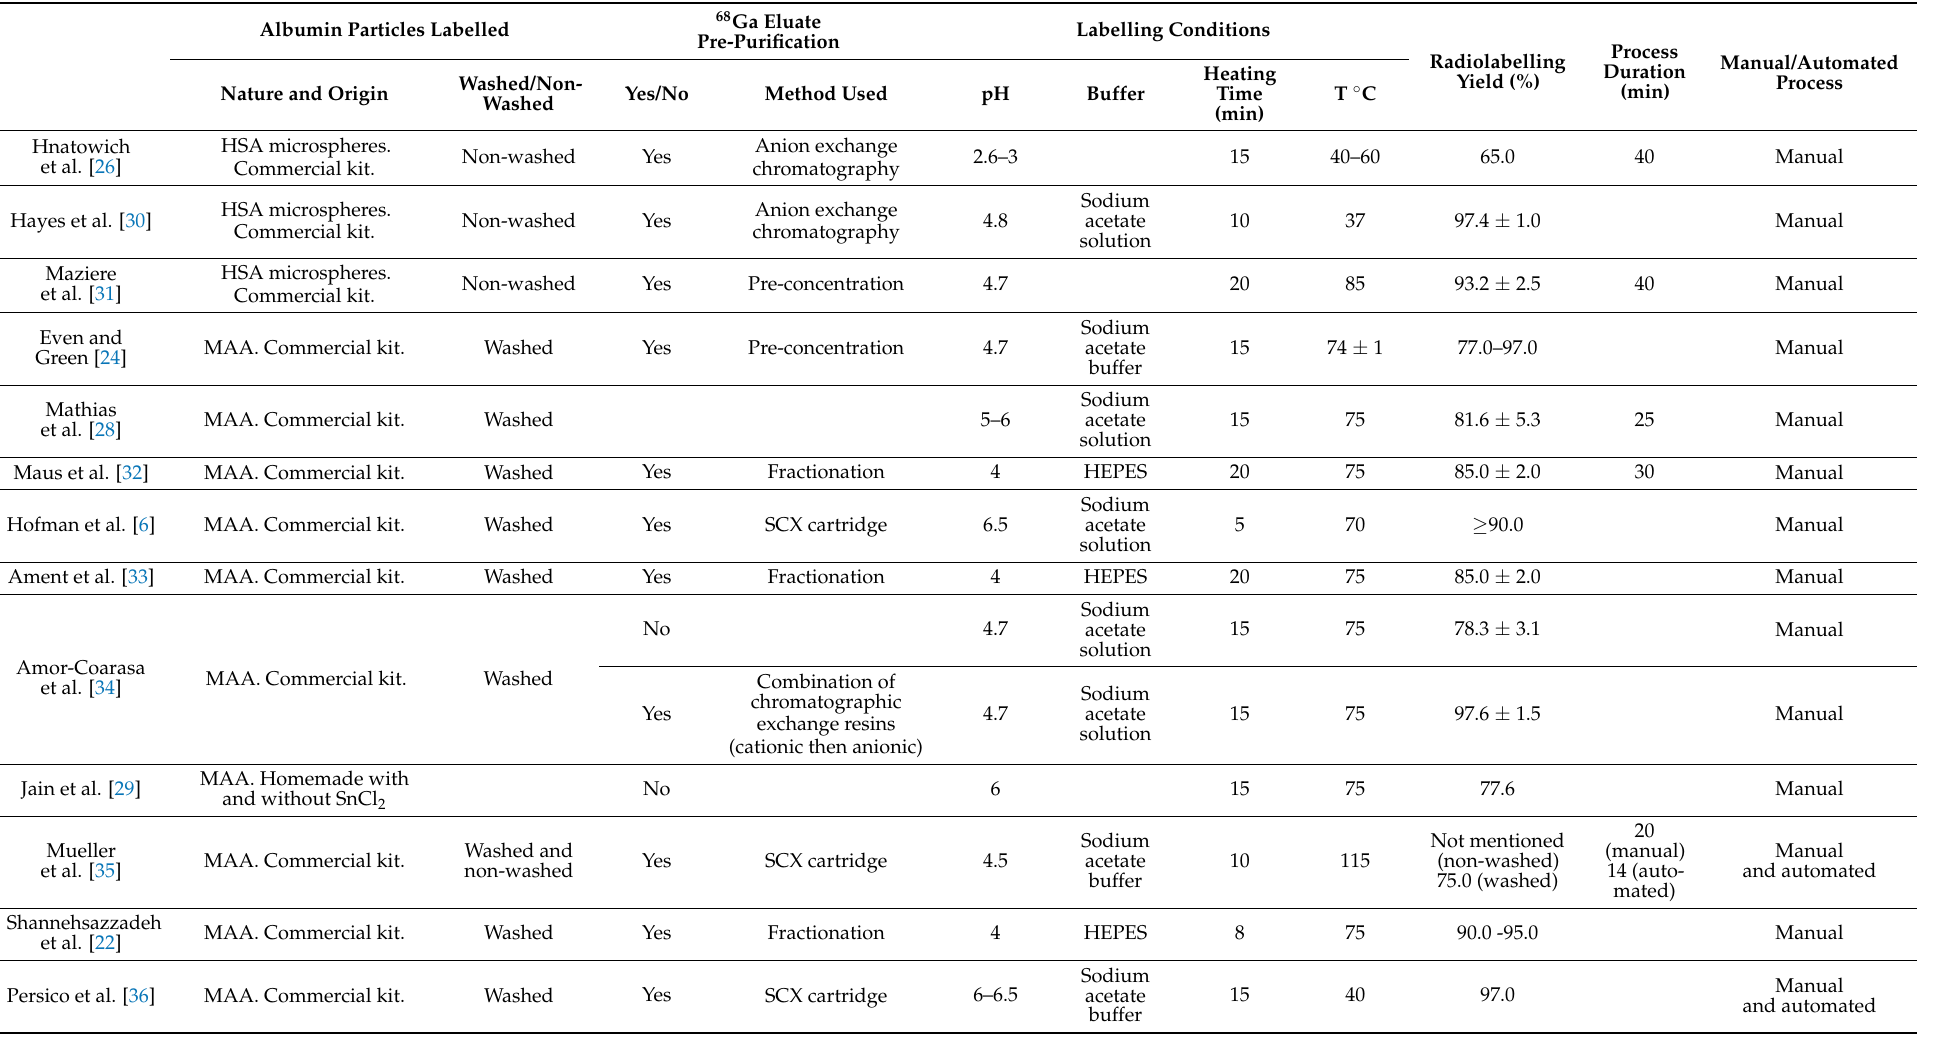
Table 1. [ 68 Ga]Ga-MAA labelling conditions of various methods described in the literature. Albumin Particles